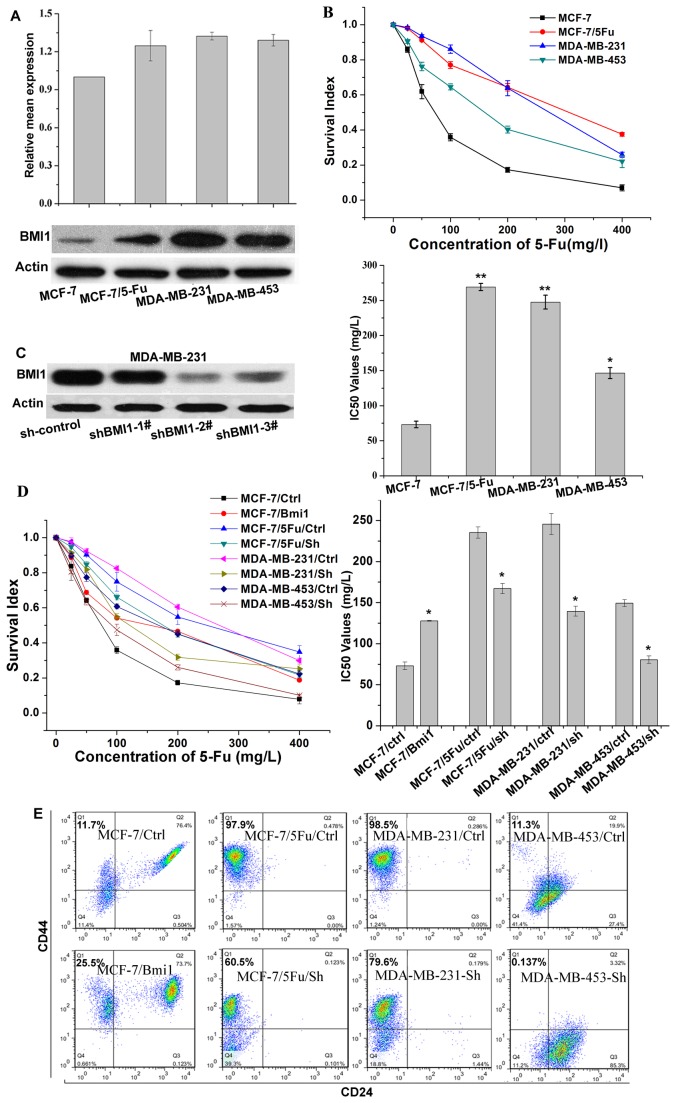
Bmi1 expression pattern and its role in 5-Fu resistance in breast cancer cells.(A) mRNA (up) and protein (down) expression levels of Bmi1 in selected breast cancer cells; (B) Dose-survival index curves (up) were plotted from MTS assay results from three independent experiments and IC50 values (down) for 5-Fu were calculated in selected cell lines with differentail expression of Bmi1, vs MCF-7, * p<0.05, ** p<0.01; (C) MDA-MB-231 cell line was selected for verifying the knockdown efficiancey of Bmi1 specific shRNAs; (D) Dose-survival index curves (left) were plotted from MTS assay results from three independent experiments and IC50 values (right) for 5-Fu were calculated in ectopic Bmi1 overexpressed or Bmi1 knockdown cell lines, vs control, * p<0.05; (E) FACS analysis of cell-surface marker CD44 and CD24 in cell lines to indicate the breast cancer stem cell subpopulation.